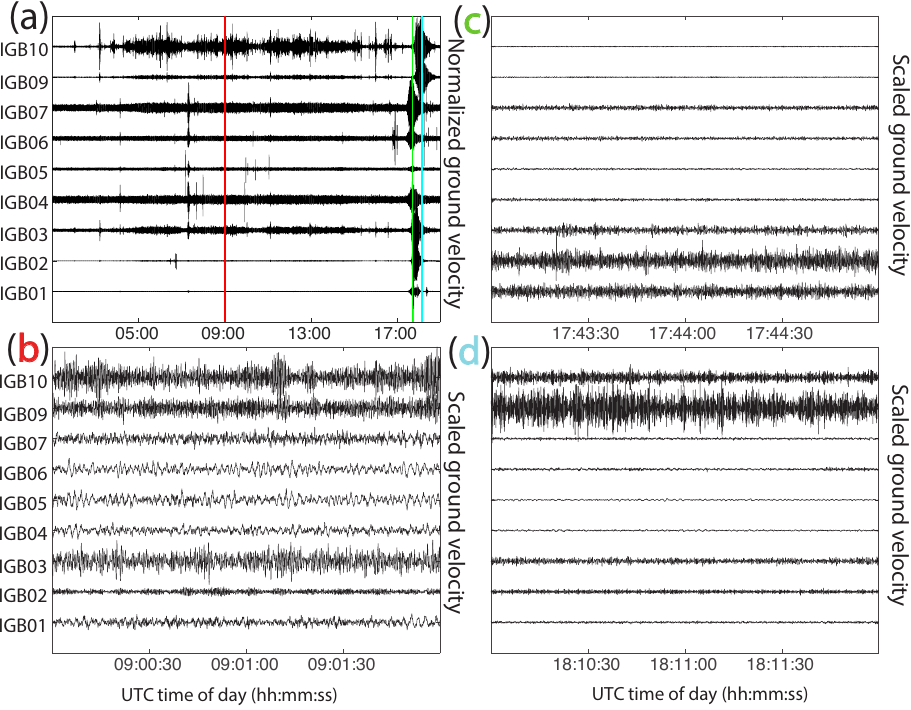
IGB01IGB02IGB03IGB04IGB05IGB06IGB07IGB09IGB10 Figure 6. Debris-flow seismograms and pre-event noise for the event on 19 June 2011. (a) Record showing the debris-flow event around 18:00 and pre-event background noise. (b) , (c) and (d) show 2-minute records at the time instances denoted by the red, green and cyan bars in (a) . The different amplitude distributions during the two debris-flow records (c, d) testify to the motion of the seismogenic debris-flow front through the monitoring network. Note that amplitudes in (a) are normalized to each trace, whereas amplitudes in (b) , (c) and (d) are normalized to the maximum across all